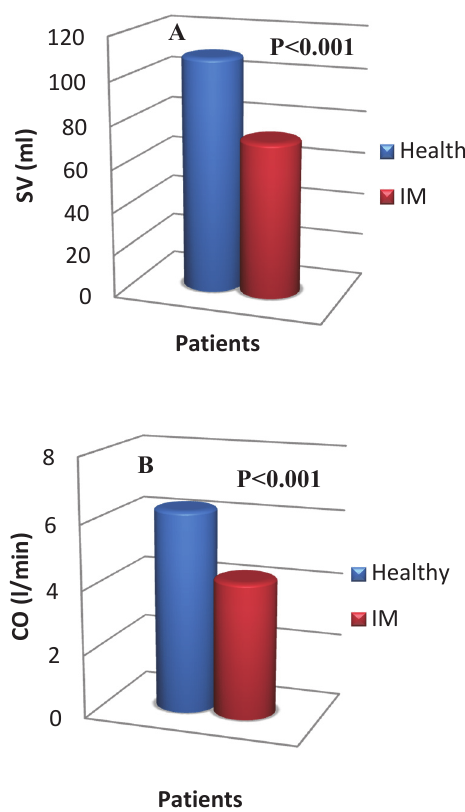
Fig.4: Difference between patients with mitral insufficiency (red) and control subjects (blue): (A) Histogram of stroke volume, (B) Histogram of cardiac